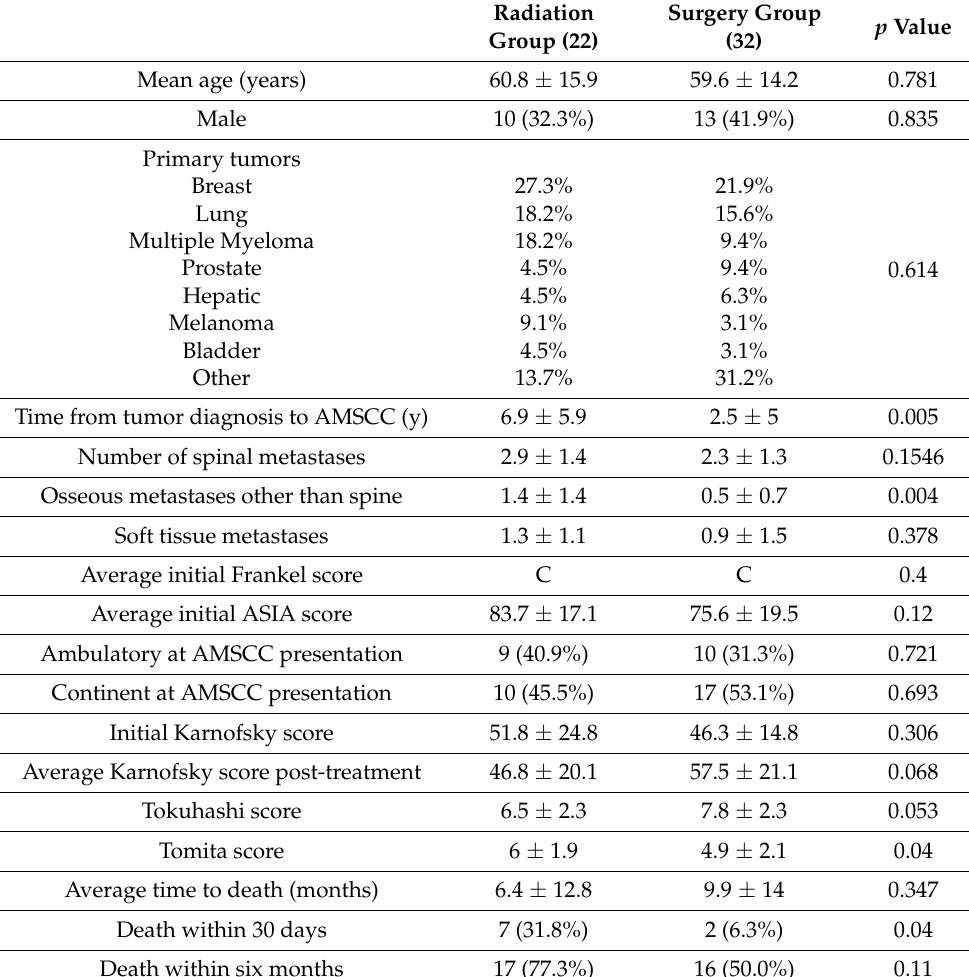
Table 1. Baseline characteristics of